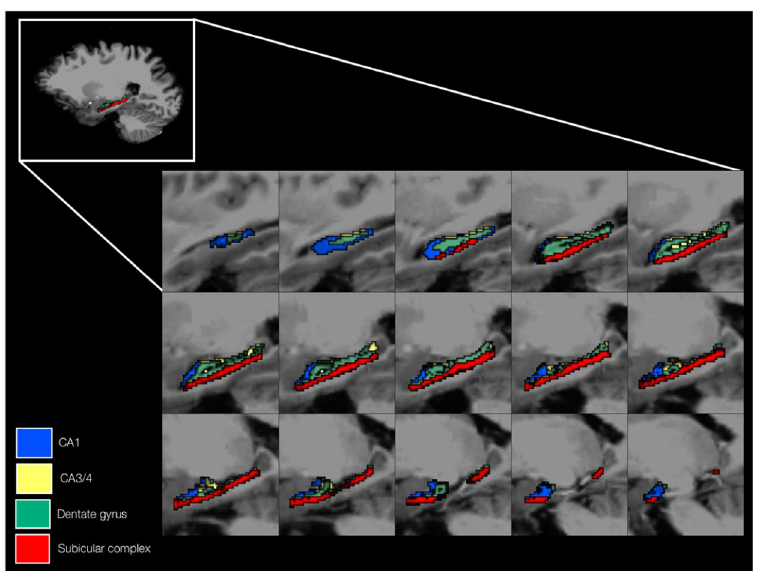
Figure 3. An anatomical representation of the hippocampal subfields, with the subiculum, presubiculum, parasubiculum, CA1, CA3, CA4, granule layer of the dentate gyrus and molecular layer of the dentate gyrus grouped into CA1, CA3/4, dentate gyrus and subicular complex regions. Volume metrics of CA1 and CA3/4 exhibited negative associations with MDD